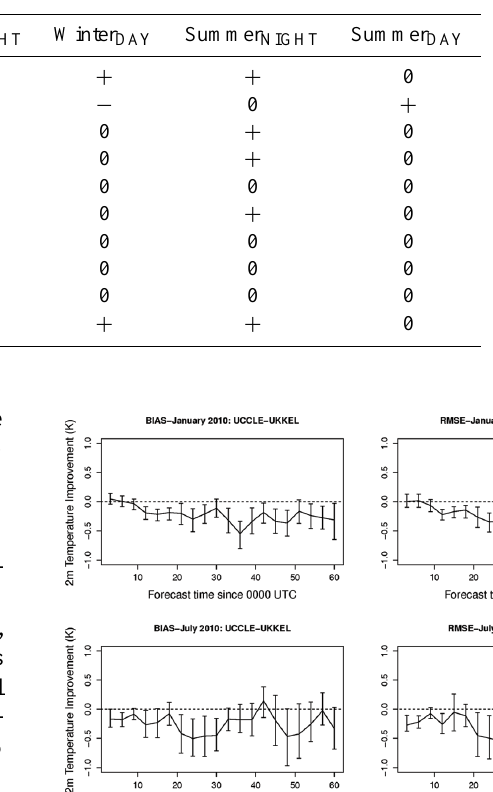
Table 2. The average daytime/night-time scores for the flat/high-elevation and coastal synoptic stations. The + sign means improvement, 0 means neutral effect and the − sign means degradation of the scores.